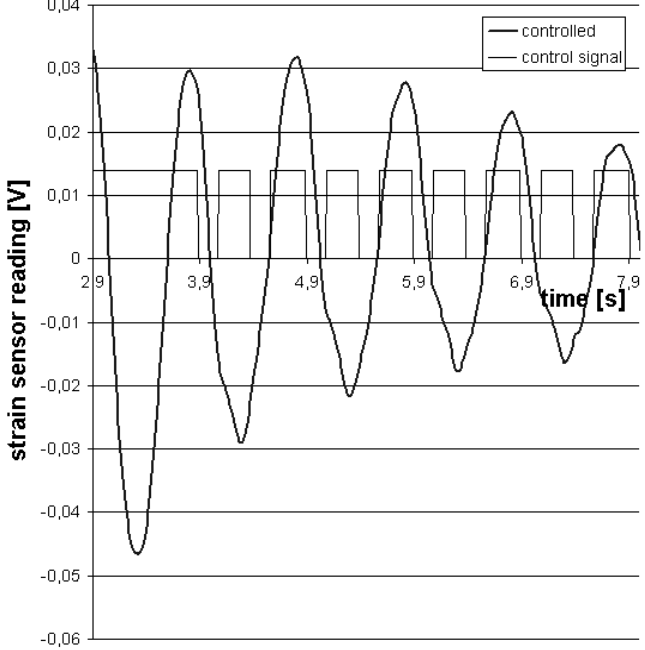
Fig. 18. Weak effect due to wrong delamination trigger